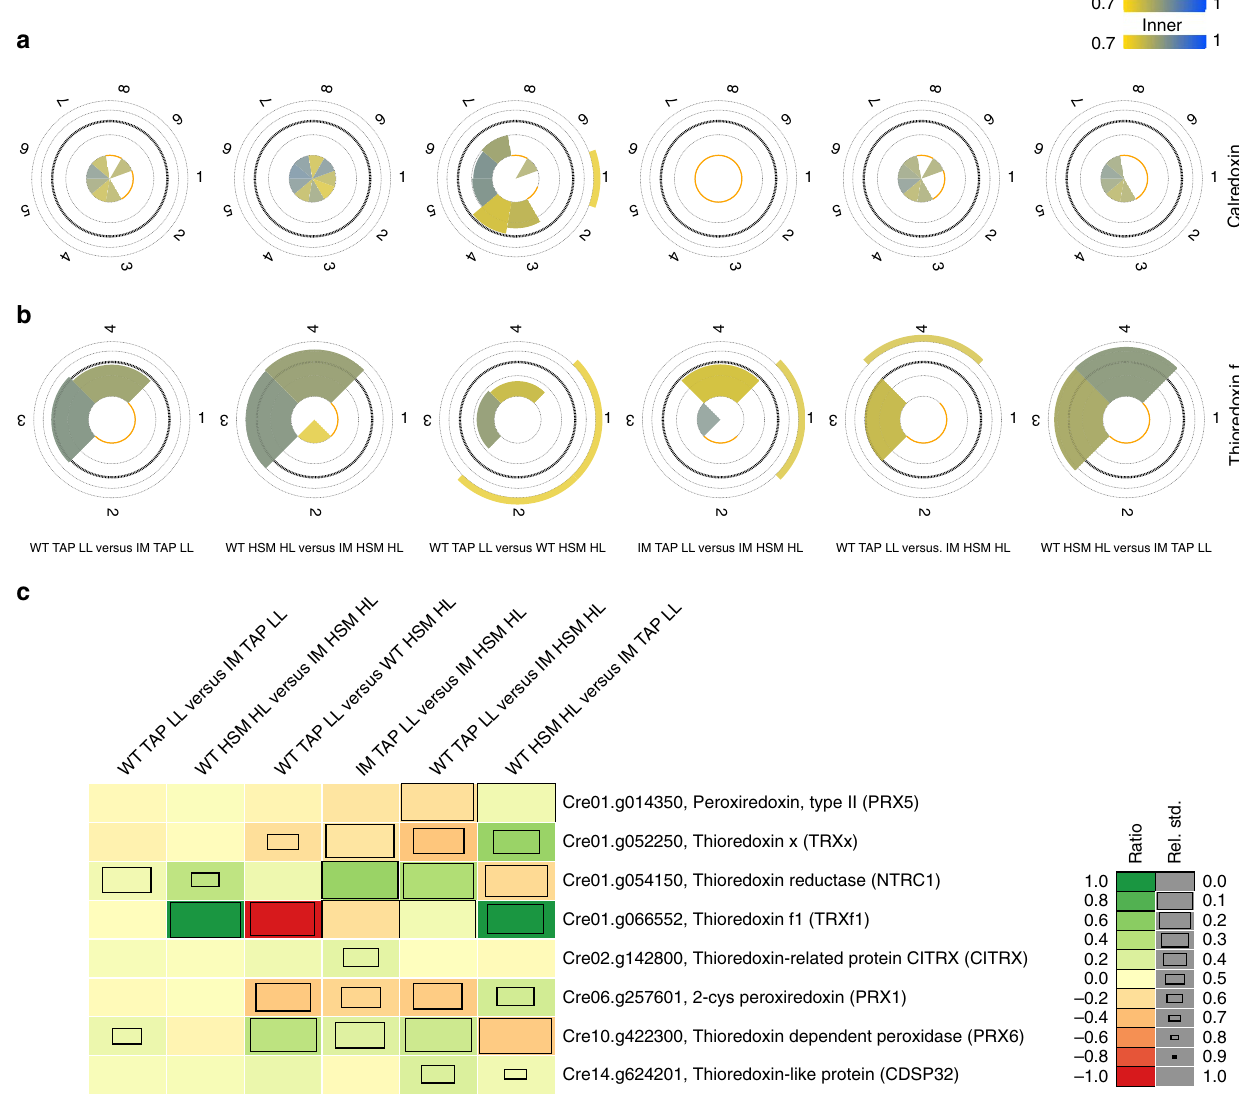
(TRX:PRX4-peptide) 45 . A mammalian PRX4 existed as a ring-